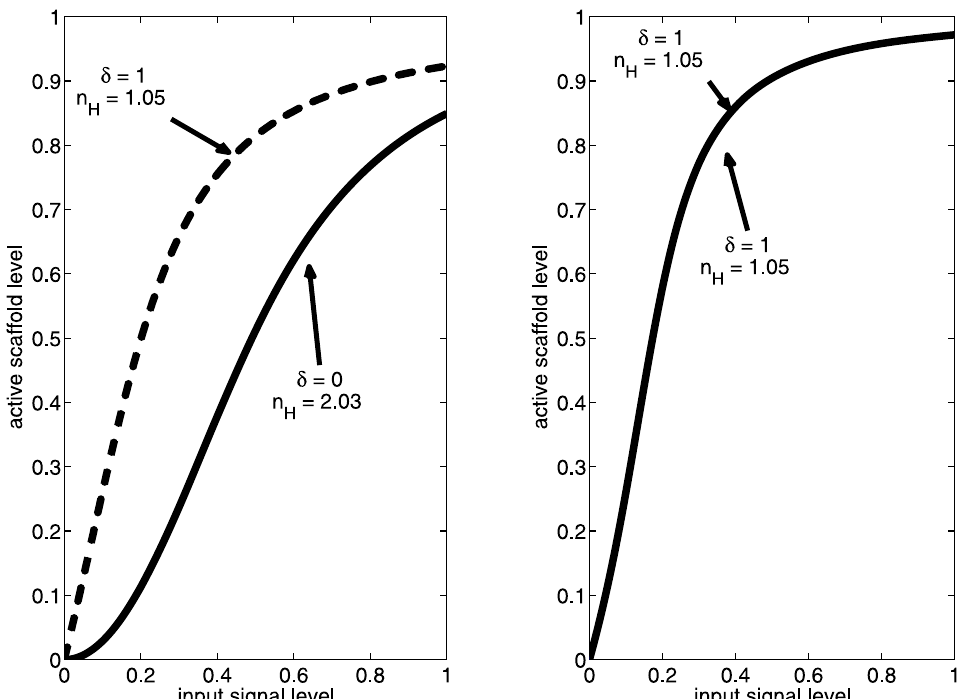
Figure 6. Signal response of the scaffold-MAPK complex in the presence ( d ~~ 1 ) or absence ( d ~~ 0 ) of constitutive x 1 binding. Plots represent slow ( k on ~ 1 , left panel) or fast ( k on ~ 100 , right panel) scaffold-membrane association rates.